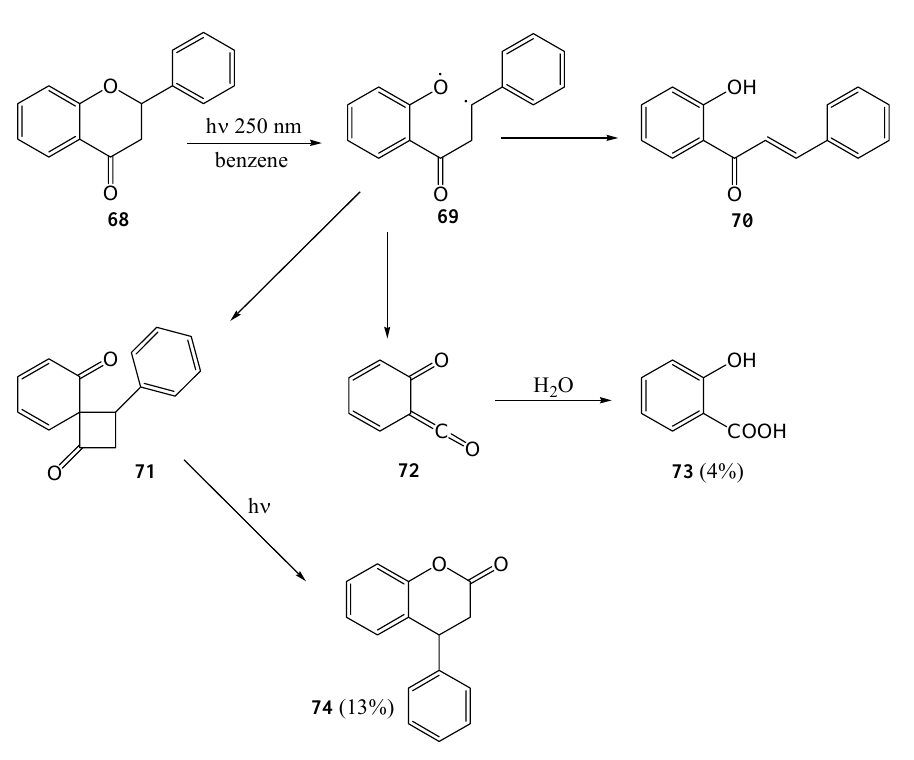
Scheme 27. Photochemistry of